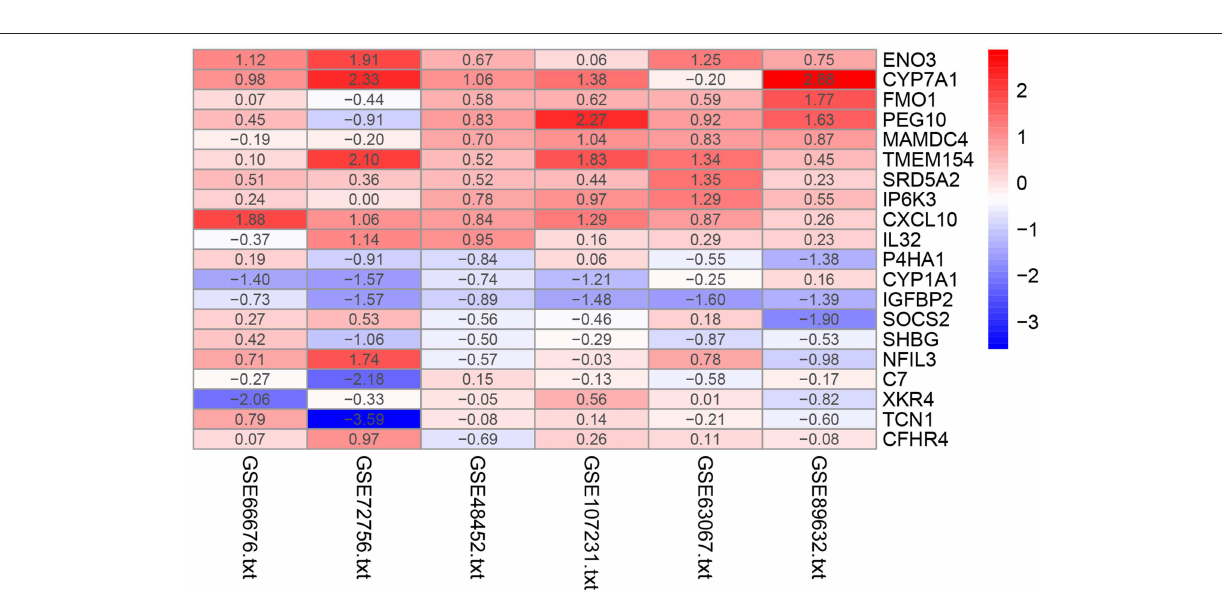
Frontiers in Endocrinology |